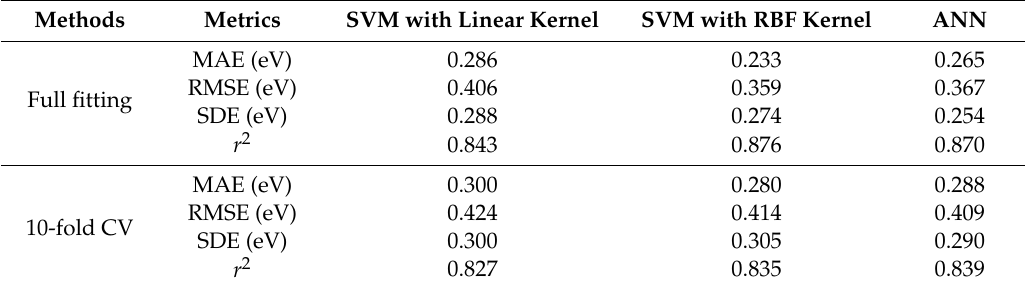
Figure 2. Comparison of ∆ E SE from the density functional theory (DFT) calculations and the full-fit results from the three machine learning models with four input features. ( a ) Support vector machine (SVM) model with linear kernel, ( b ) SVM model with radial basis function (RBF) kernel, and ( c ) artificial neural network (ANN). Table 1. Values of mean absolute error (MAE), root mean square error (RMSE), square correlation coefficient (SDE) and r 2 from full fit and 10-fold cross validation predictions of three machine learning models with four input features. SVM: support vector machine; RBF: radial basis function; ANN: artificial neural network.